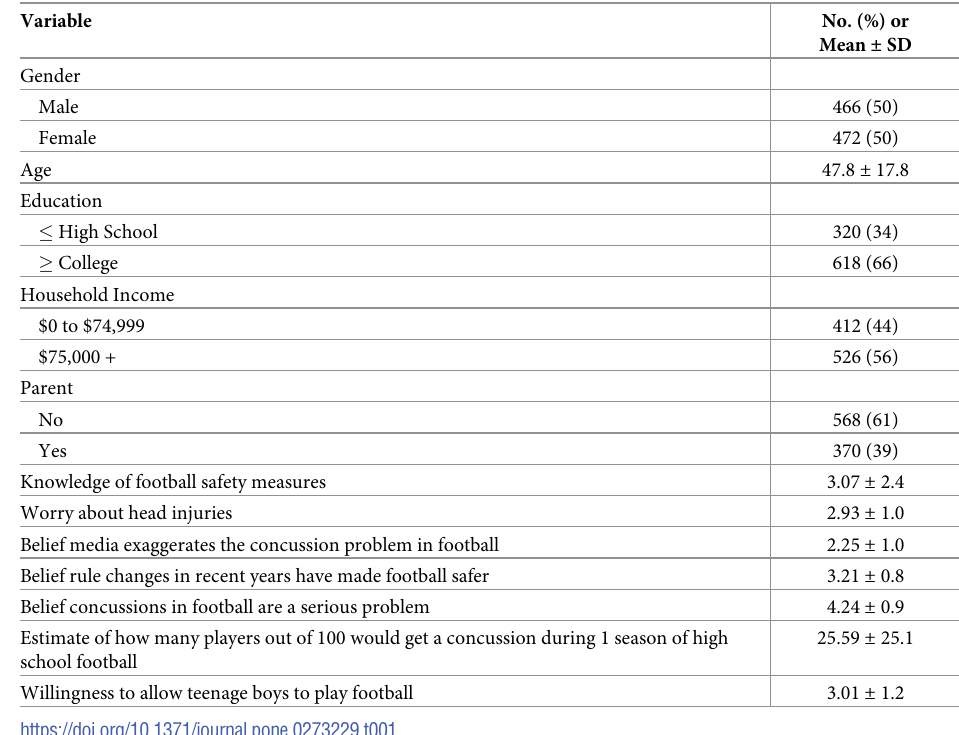
Table 1. Weighted sample characteristics ( n =